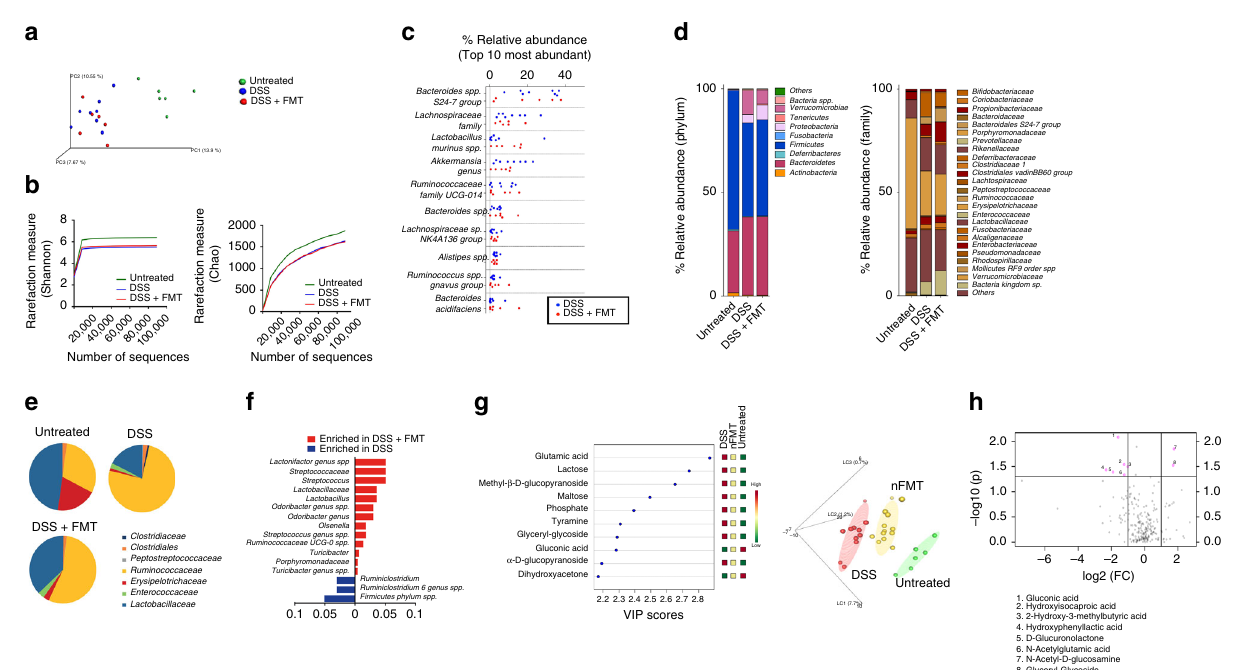
Fig. 2 Gut microbiota analysis upon FMT treatment in colitic mice. a Microbiome clustering based on unweighted Principal Coordinate Analysis (PCA) UniFrac metrics of fecal gut microbiota derived from DSS treated (blue dots), DSS + FMT-treated (orange dots) and untreated (red dots) mice. b Relative abundance of the top 10 most abundant OTUs in DSS (blue) and DSS + FMT (red) treated mice. c Rarefaction curves showing microbial richness based on the Chao1 index (bottom panel) and microbial richness and evenness on the Shannon index (upper panel). Green lines, untreated, blue lines, DSS treated; red lines, DSS + FMT-treated samples. d Bar plots of the taxonomic composition showing relative abundances > 1% of bacterial phyla (d, left panel) and families ( d , right panel). e Pie charts showing the relative abundance of the less abundant families belonging to the Firmicutes phylum. f Comparison of the relative abundances of different taxa between DSS (blue) and DSS + FMT (red) treated mice. Statistical signi fi cant difference was assessed through One- way ANOVA with LSD post-hoc test * p < 0.05, ** p < 0.01. g , h Partial Least square-discrimination analysis (PLSD-DA, g) and volcano plot (h) on metabolomics data (g, right panel) and heat map of metabolites that have contributed most to class separation (g, left panel) of faecal samples of untreated, DSS and DSS + FMT-treated mice. Statistical signi fi cant difference was assessed through Mann – Whitney. In ( a – f ) UT n = 6, DSS n = 8, DSS